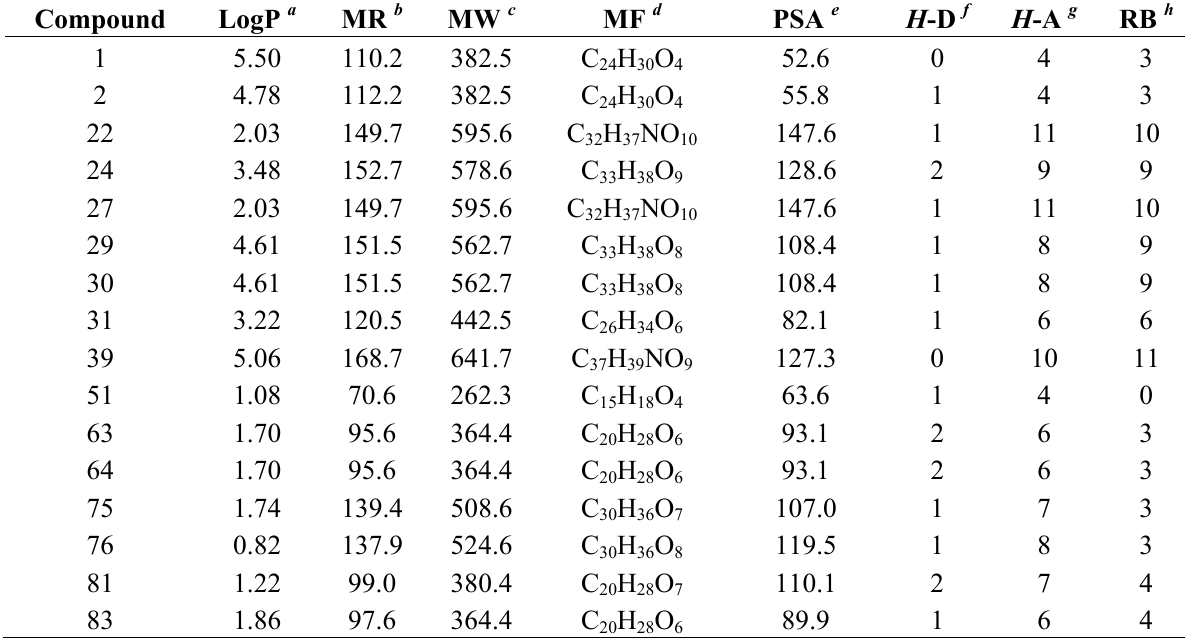
Table 4. Calculated druglikeness properties for strongest-docking sesquiterpenes.